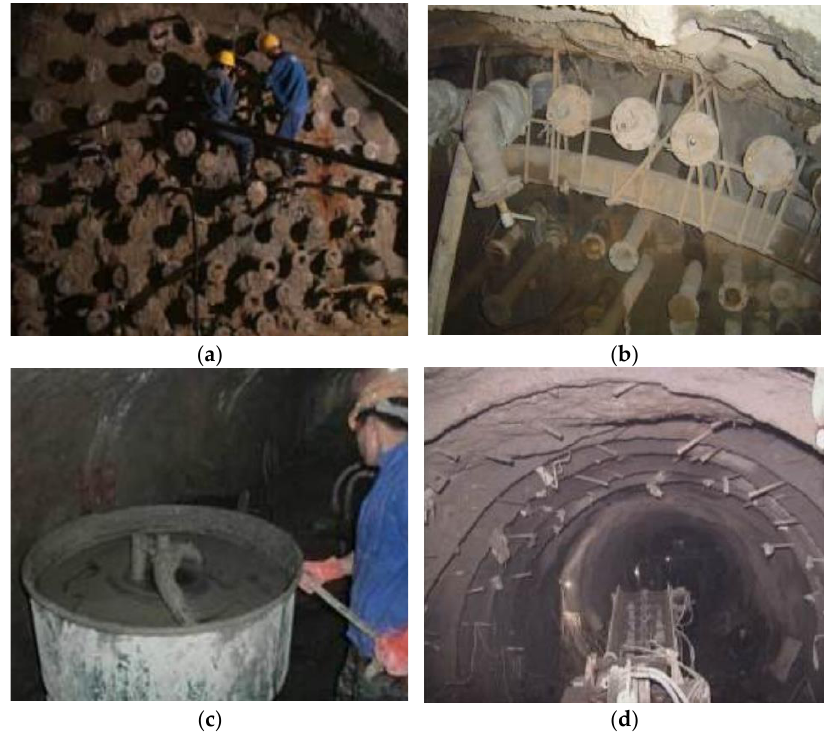
Figure 19. Processes of composite grouting [109]. ( a ) Advanced curtain grouting, ( b ) secondary re- inforcement grouting, ( c ) localized infill grouting, ( d ) radial grouting. (2) Backfilled